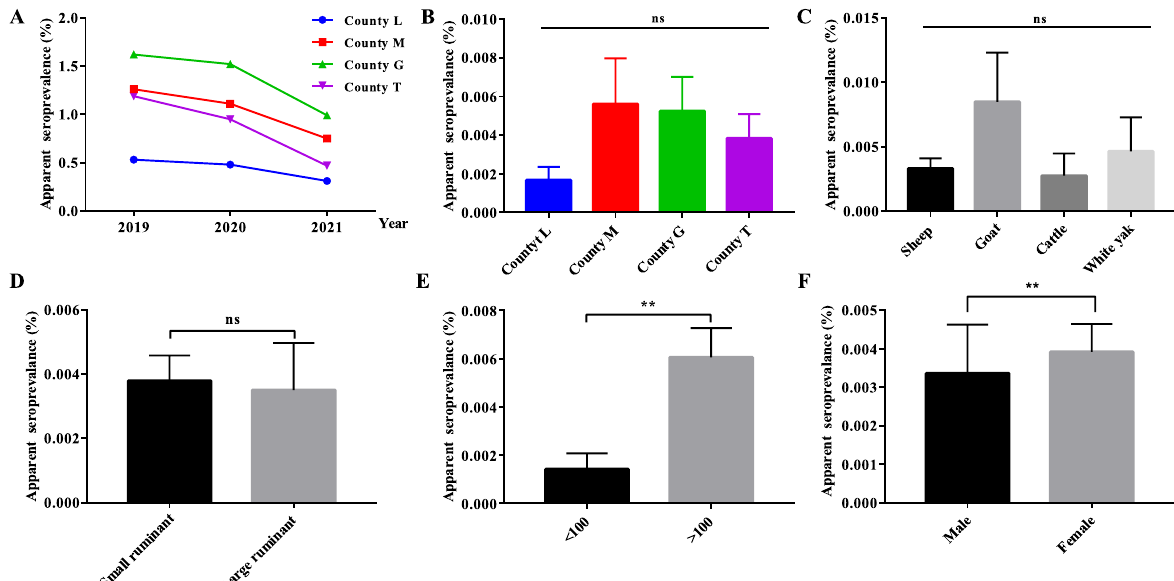
Fig. 2 The individual-level apparent seroprevalence of animal brucellosis from 2019 to 2021. A The trends of apparent seroprevalence in four counties from 2019 to 2021; the Y-axis represents the average individual-level positive rate of the county with seroprevalence % X-axis represents years. B Differential analysis of apparent seroprevalence in different counties; C Differential analysis of apparent seroprevalence in different species; D Differential analysis of apparent seroprevalence in small and large ruminants; E Differential analysis of apparent seroprevalence in different flock sizes; F Differential analysis of apparent seroprevalence in different sexes. ns: no significant difference at P > 0.05. * Significant difference at P < 0.05. ** Extremely significant difference at 0.01 < P <